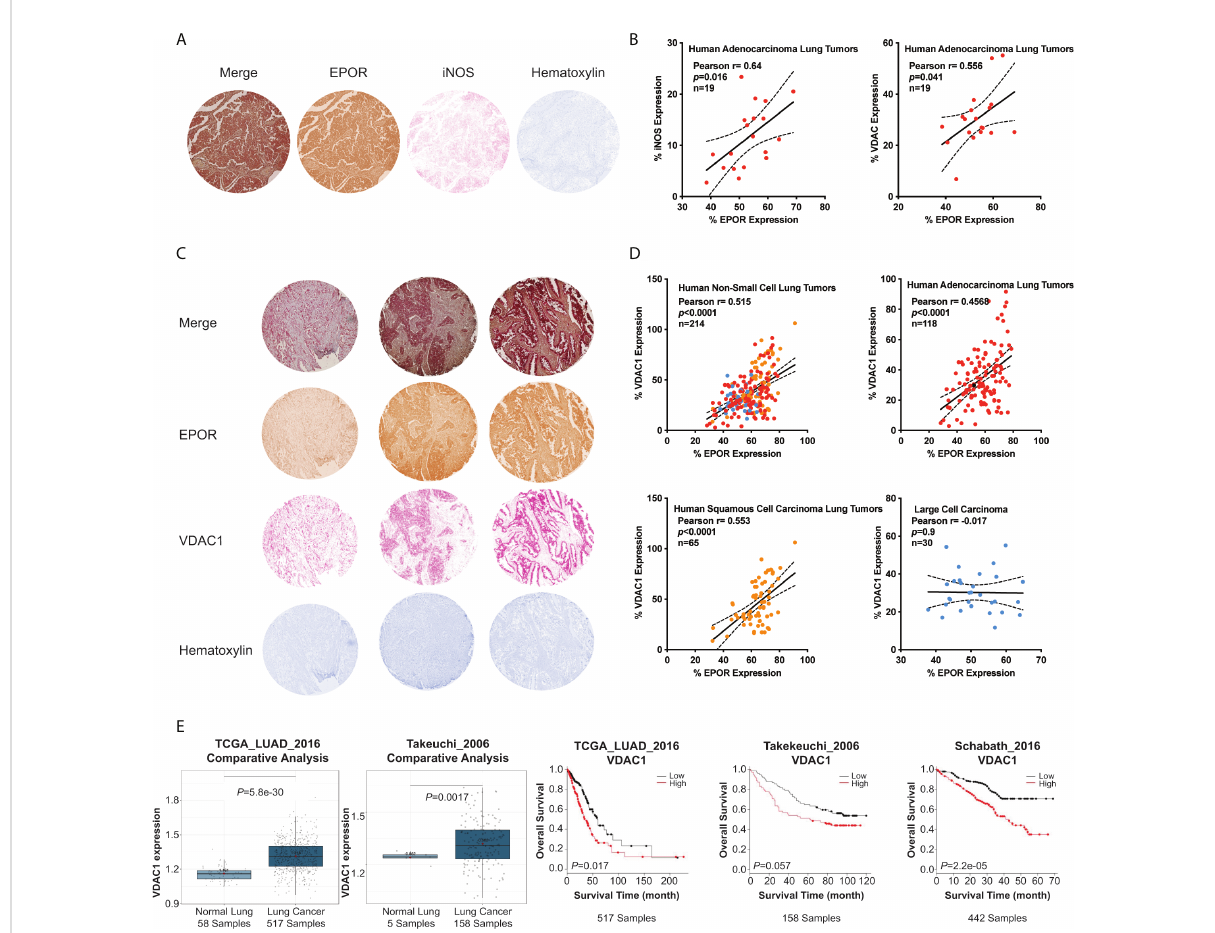
FIGURE 6 EPOR expression correlates with VDAC1 expression in human lung cancer biopsies. Human non-small lung cancer tissue arrays were immunohistochemically stained for EPOR, VDAC1, and iNOS. (A) Shown is a representative tumor core image stained for EPOR (brown), iNOS (red), and counterstained with hematoxylin (blue). (B) EPOR and iNOS expression (left panel), as well as EPOR and VDAC1 expression (right panel), were quanti fi ed by ImageJ and normalized to the total measured tumor core area. Shown are Pearson correlation analyses of normalized EPOR (x-axis) and iNOS and VDAC1, respectively (y-axis) expression levels (in %) from tumor core images of human lung adenocarcinoma (n=19). (C) Shown are three representative tumor core images stained for EPOR (brown), VDAC1 (red), and counterstained with hematoxylin (blue). (D) EPOR and VDAC1 expression (i.e., stained area) were quanti fi ed by ImageJ and normalized to the total measured tumor core area. Shown are Pearson correlation analyses of normalized EPOR (x-axis) and VDAC1 (y-axis) expression levels (in %) from all tumor core images (upper left panel; n=214) or tumor core images of human adenocarcinoma lung tumors (upper right panel; red; n=118), human squamous cell carcinoma lung tumors (lower left panel; orange; n=65) and human large cell carcinoma (lower right panel; blue; n=30). (E) Analyses of VDAC1 mRNA expression in lung adenocarcinoma patients using the lung cancer explorer (37). The fi rst and second panels show VDAC1 levels in normal lungs and lung adenocarcinoma in the TCGA_LUAD_2016 study (1 st panel) (38) and from Takeuchi_2006 study (2 nd panel) (39). In panels 3-5, Kaplan-Meier survival curves show an association between overall survival of lung adenocarcinoma patients and the mRNA expression of VDAC1 in the TCGA_LUAD_2016 study (3 rd panel) (38), the Takeuchi_2006 study (4 th panel) (39), and the Schabath_2016 study (5 th panel) (40). The datasets were split into low and high VDAC1 expression by using the overall mean of VDAC1 expression and were analyzed with a log-rank